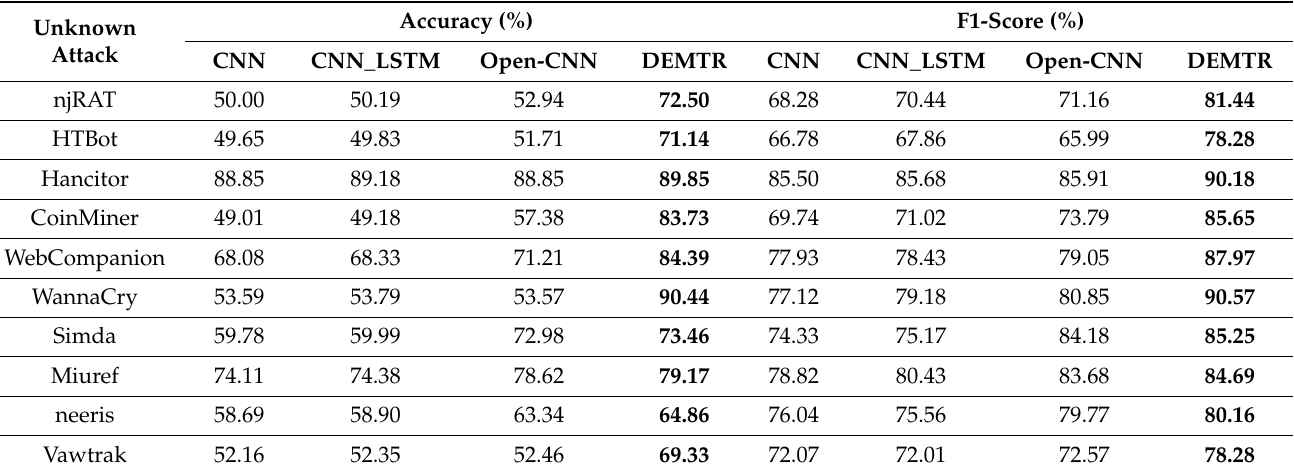
Table 3. Performance comparison between the proposed DEMTR model and the baselines in detecting single-type unknown